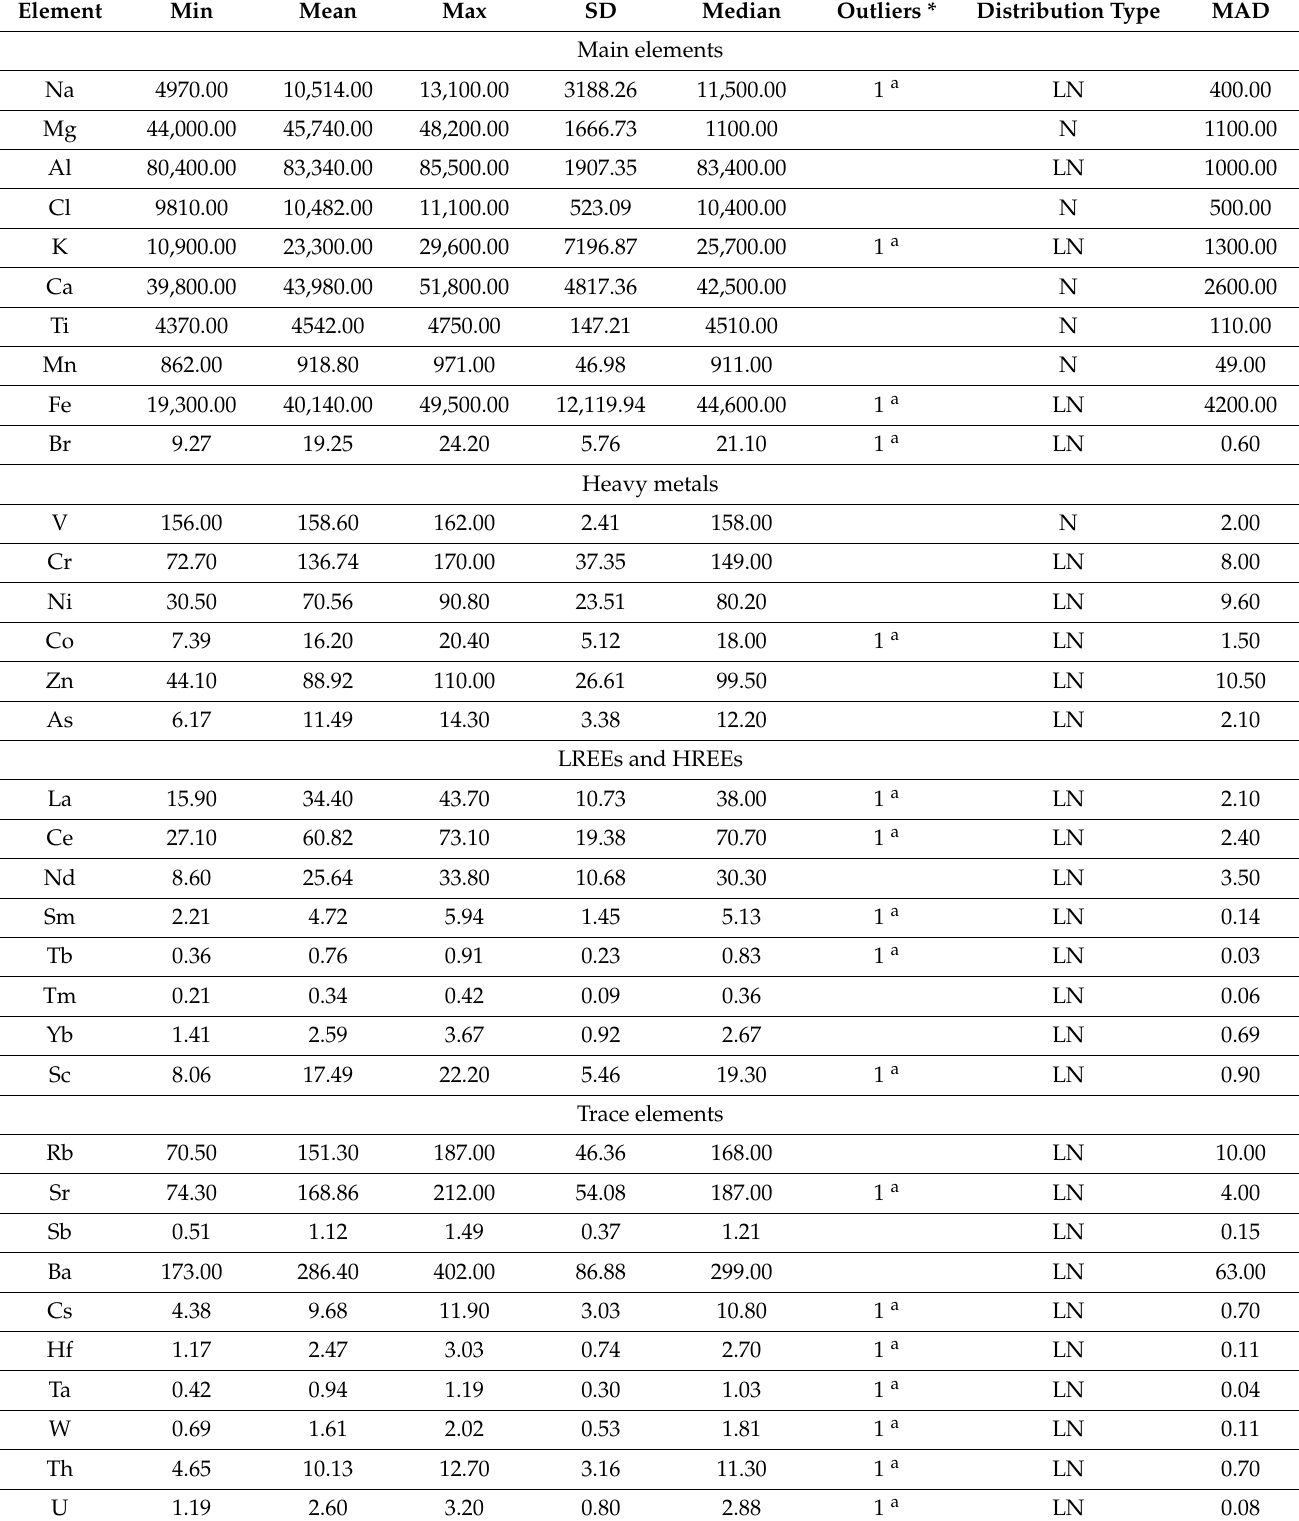
Table 3. Elements concentration in the Caineni Lake bottom sediment core (72–82 cm) in mg · kg − 1 . N normal distribution, LN log-normal